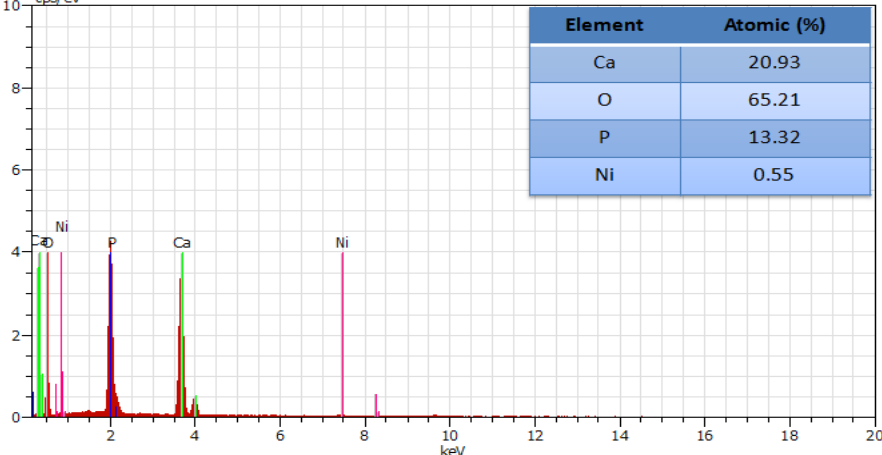
Figure 5. EDAX spectrum of Ni 2+ -doped HApNPs calcined at 500 °C.